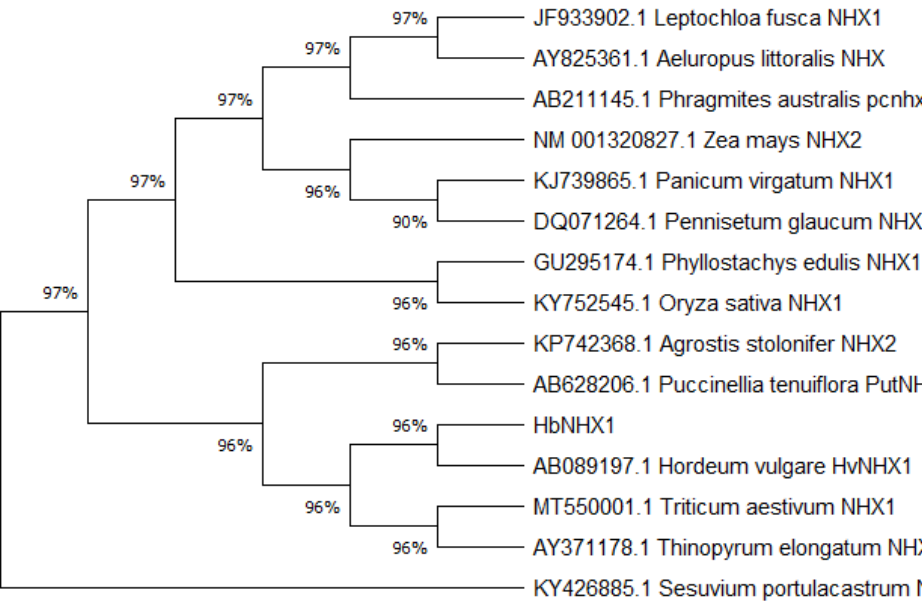
Figure 5. Evolutionary tree analysis of plant NHX1 gene.